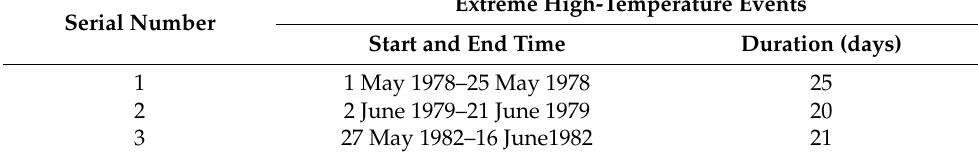
Table 2. Starting and ending time and duration of typical extreme high-temperature events in CPEC (1961 −